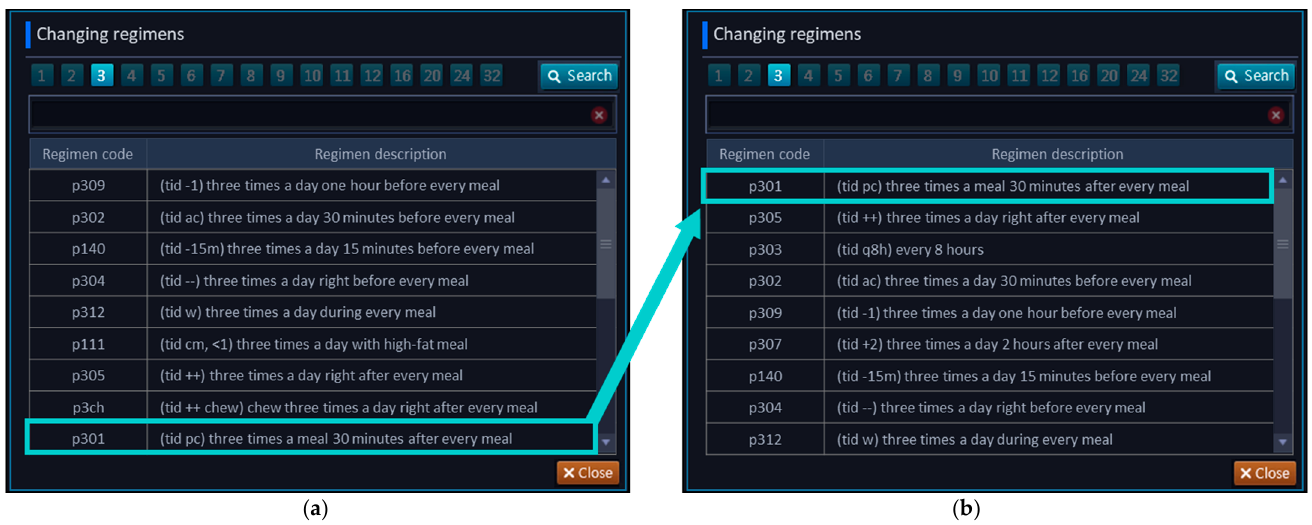
Figure 3. Rank changes of medication regimens in the CPOE system. Description of the CPOE system during the ( a ) pre-intervention and ( b ) post-intervention.